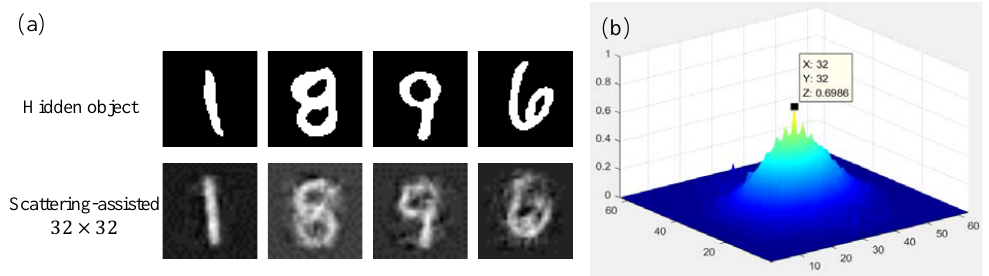
Figure 6. The performance of a single well-trained model with the dynamic scattering medium. ( a ) reconstruction results; ( b ) correlation between different shots of same object